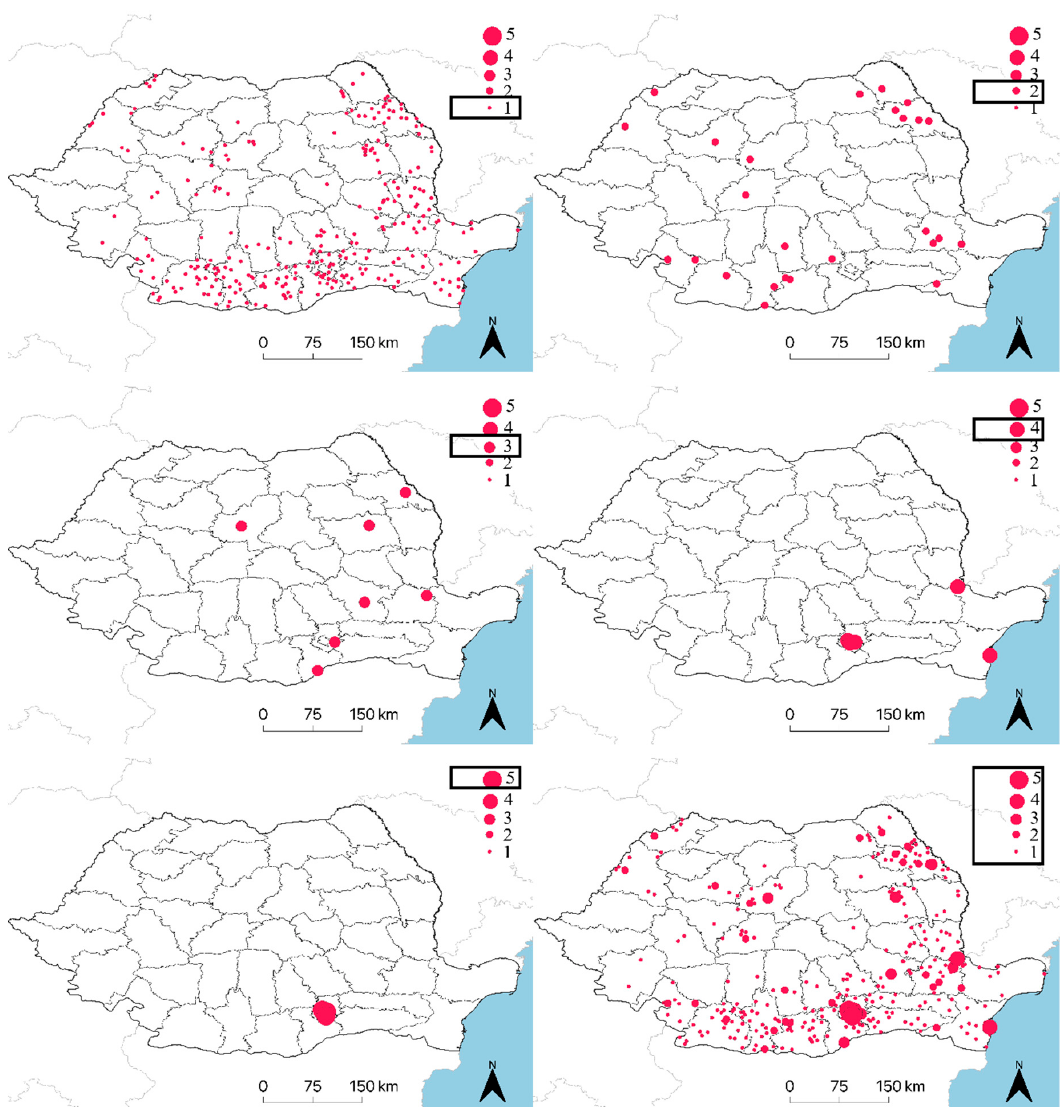
Figure 3. Annual positivity of human WNND cases for year 1, 2, 3, 4, and 5 and cumulated cases, between 2015 and 2019.